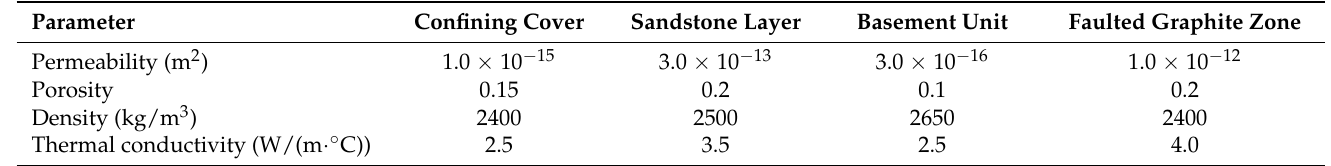
Table 1. Key physical parameters of different rock units.